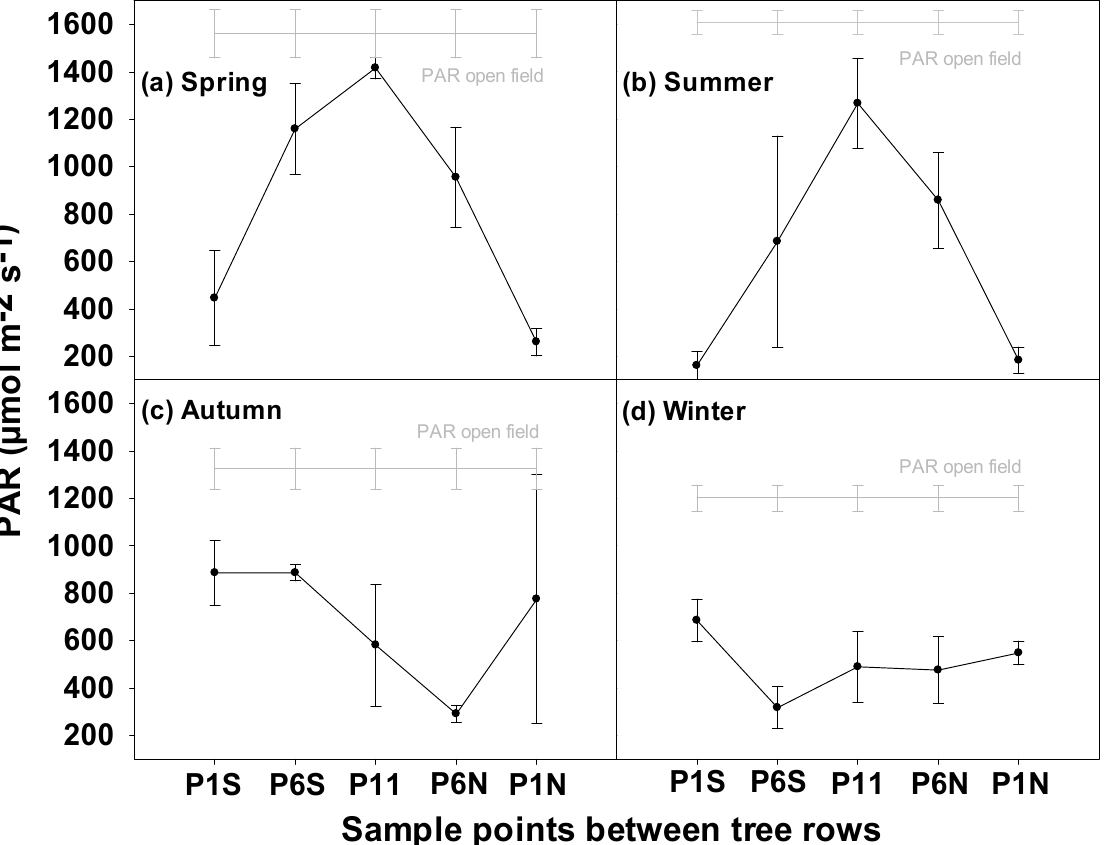
Figure 3. Mean photosynthetically active radiation (PAR; in µ mol m − 2 s − 1 ) for each sample point between the tree rows compared to PAR measured on an open field during ( a ) spring, ( b ) summer, ( c ) autumn and ( d ) winter. P1S: 1 m and P6S: 6 m from southern row. P1N: 1 m and P6N: 6 m from northern.